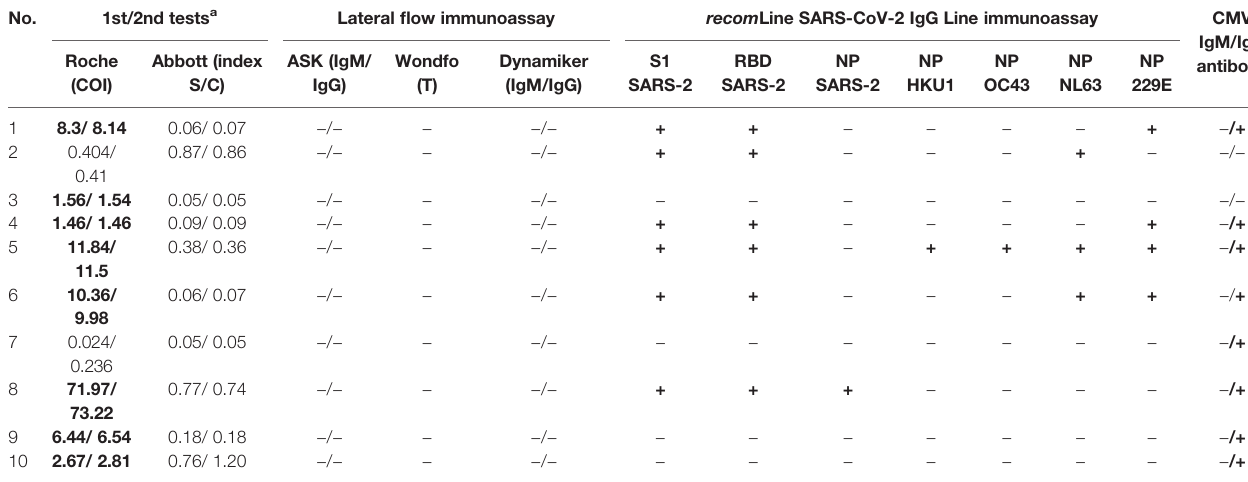
TABLE 3 | Summary of results of different antibody assays from 10 healthcare workers with virologically-documented SARS-CoV infection in 2003.